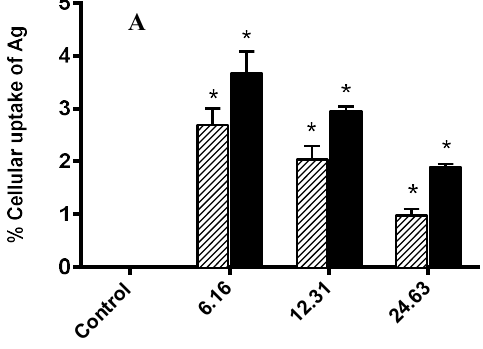
Figure 2. Cytotoxicity (% cell viability respect to the control) of GSH-AgNPs toward human gingival fibroblast cell line (HGF-1) after exposure for 30 min and 24 h. Results are presented as mean ± standard deviation. * Significant differences respect to the control ( p < 0.01).